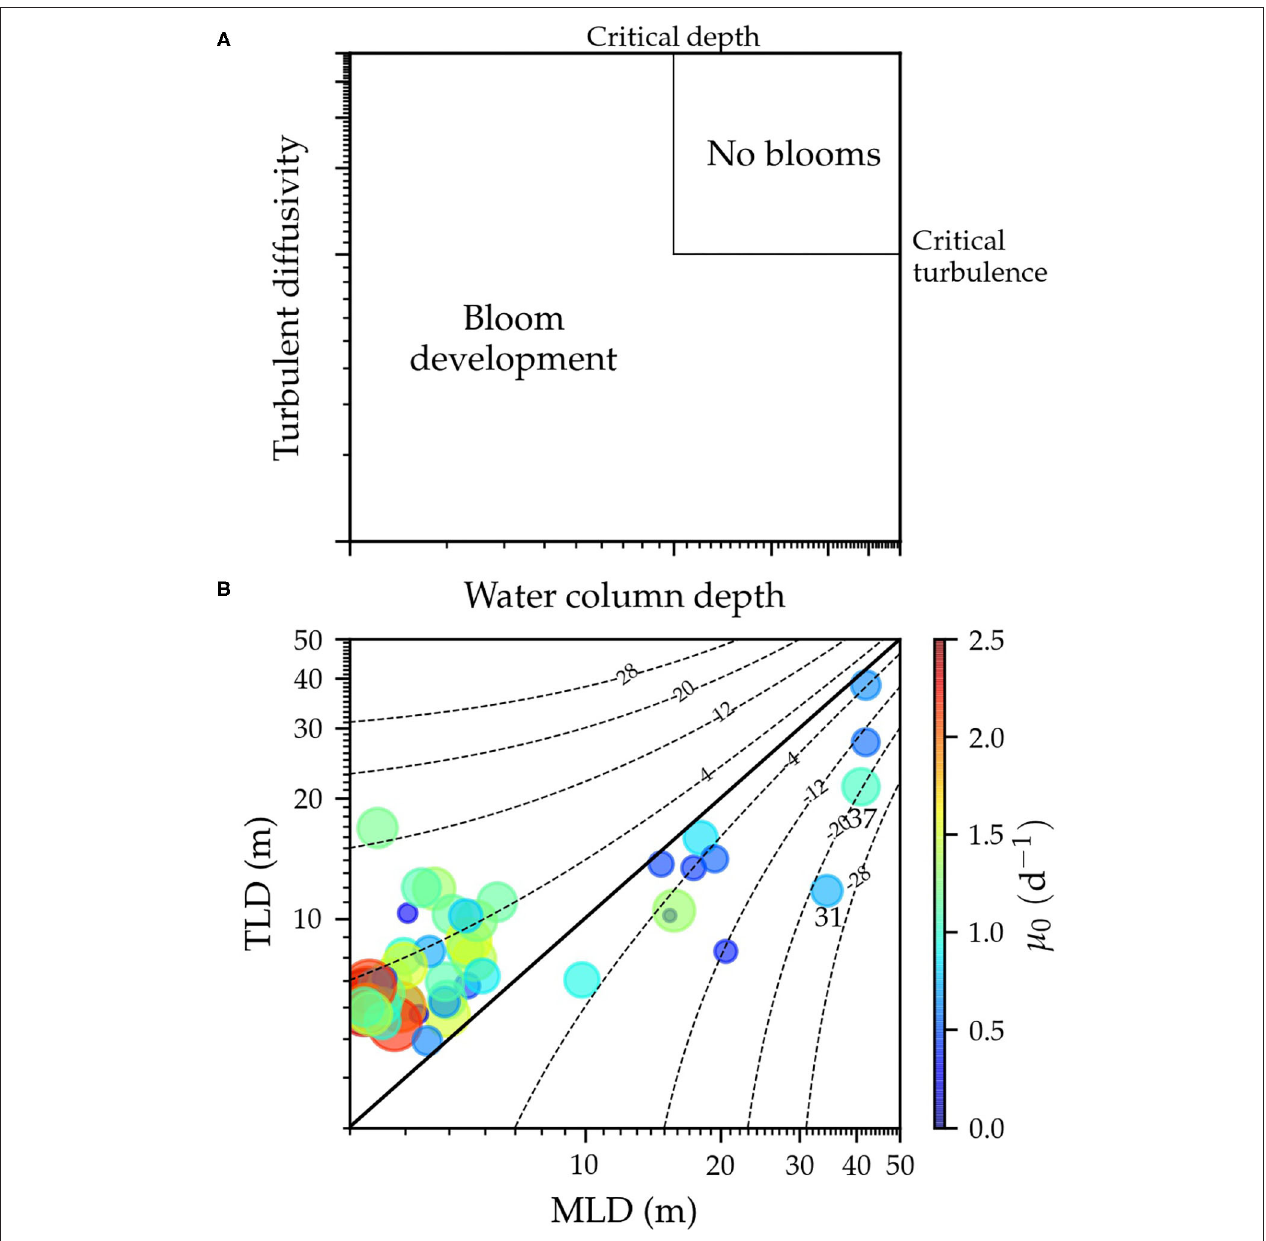
FIGURE 7 | Theoretical framework of the Critical Turbulence Hypothesis (CTH). (A) Adaptation of original diagram (Figure 2 in Huisman et al., 1999a) where critical conditions of the water column depth and turbulent diffusivity for phytoplankton bloom formation are indicated. Critical values must be interpreted for visual purposes as an approximation. (B) Phytoplankton surface growth rates ( µ 0 ) vs. the mixed-layer depth (MLD) and the turbulent layer depth (TLD). The curve of constant differences between TLD and MLD of ± 4, ± 12, ± 20, and ± 28 are represented by a dotted line and of 0 (1:1 line) by a solid line. Logarithmic scales are used in both